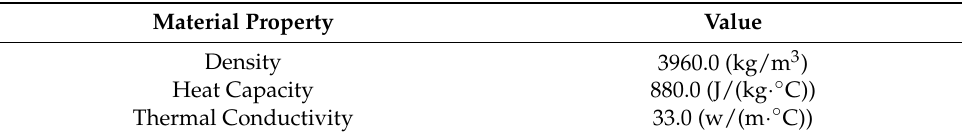
Table 3. Thermophysical properties of the MSR